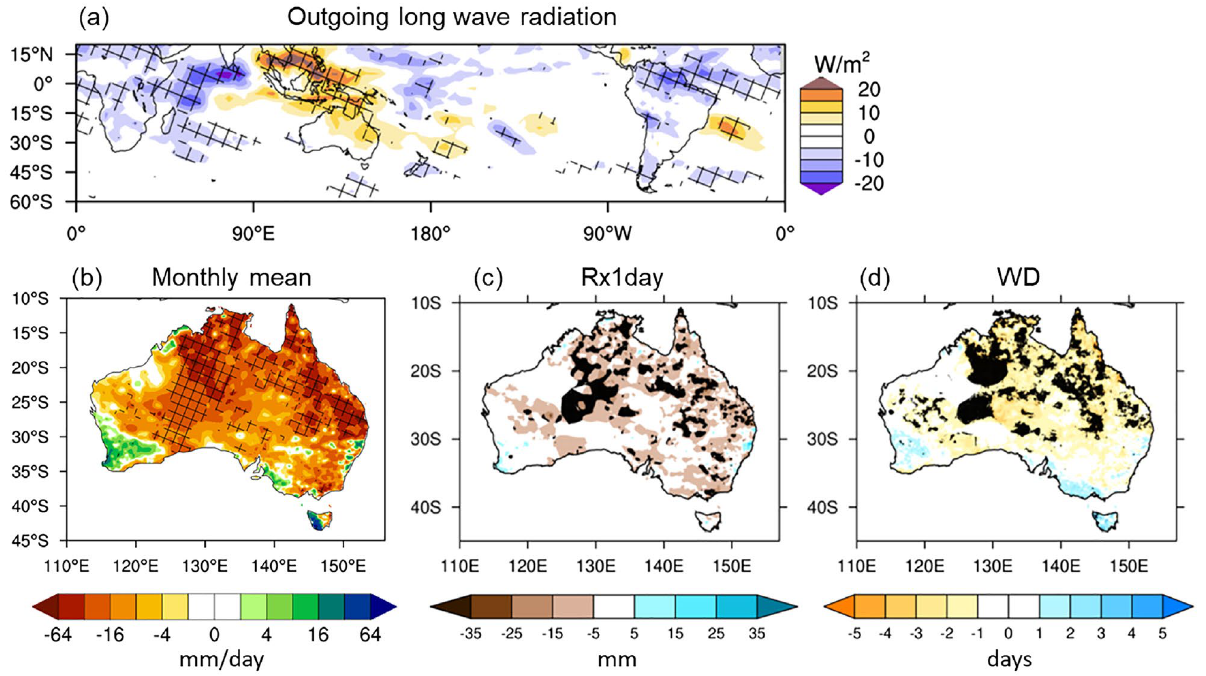
Figure 10. Composite difference between 6 highest and 8 lowest MJO812 indices during November. ( a ) Mean outgoing long wave radiation (OLR), ( b ) monthly mean rainfall, ( c ) 1-day maximum rainfall amount, and ( d ) number of wet days. Before forming the composites, the ENSO-related components were removed by regressing out the linear dependence on the Niño3.4 SST index. The hatched areas in ( a ) and ( b ) and the black coloured areas in ( c ) and ( d ) indicate statistically significant differences at the 5% level. In ( c ) and ( d ), the black shaded differences in central Australia are unlikely to be a robust feature because it is a very dry area, and